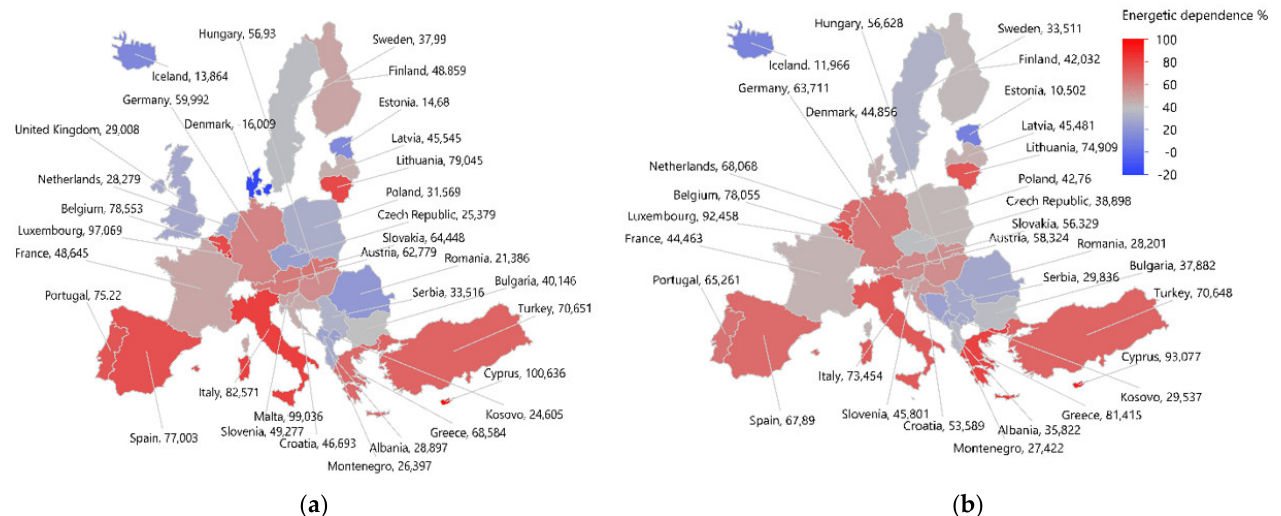
Figure 5. Cartographic representation of energy dependence for EU countries in average values in 1990–2006. Source: own processing according to [20], processing in JMP.